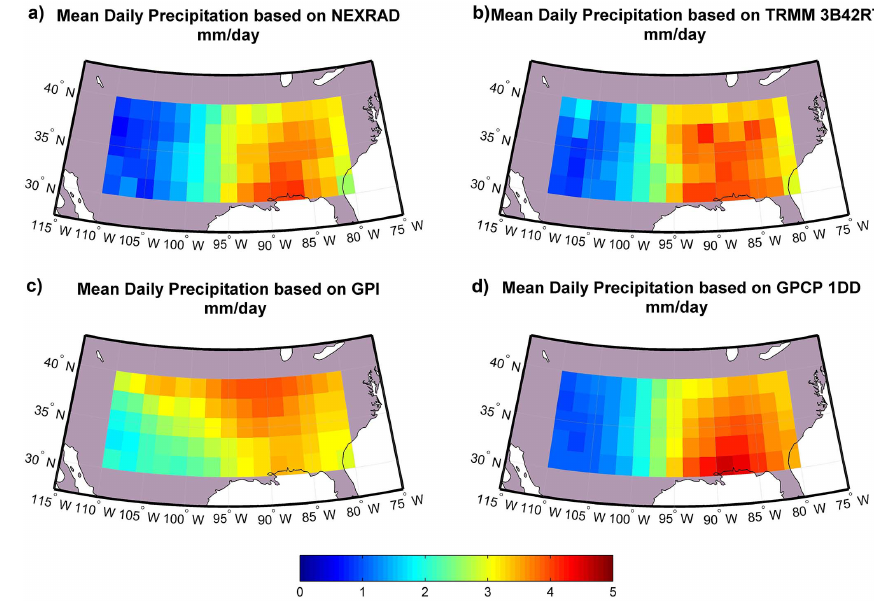
Figure 2. Climatology of precipitation across the study domain from each of the products.